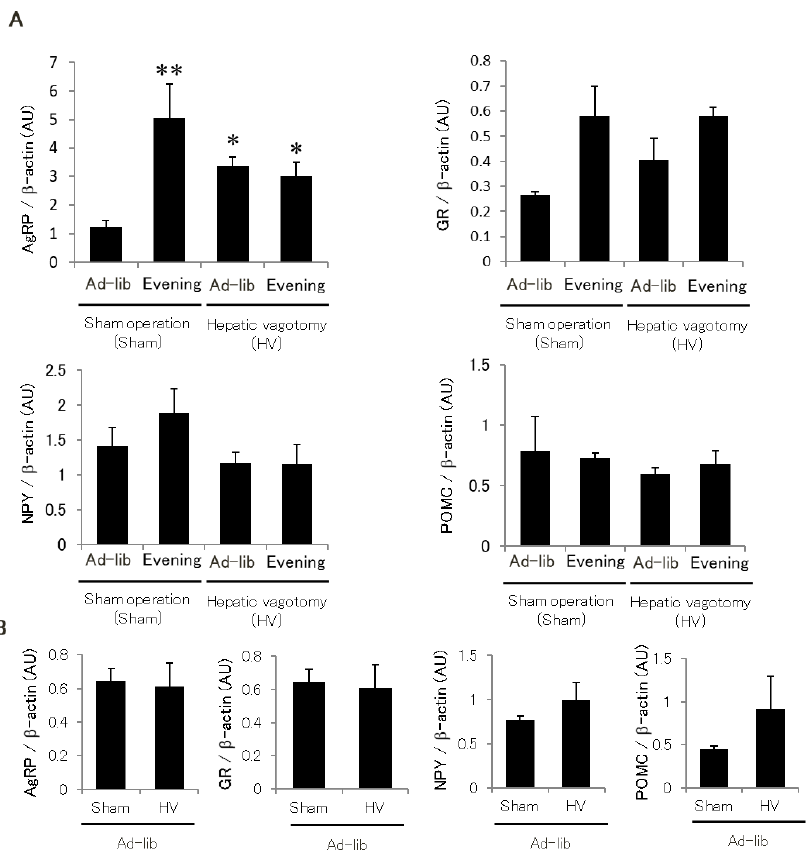
Figure 8. Effect of hepatic vagotomy on AgRP expression in ( A ) WT and ( B ) AgRP-GR-KO mice. ( A ) Hypothalamic AgRP, NPY, POMC and GR expression in WT mice with or without hepatic vagotomy ( n = 5). ( B ) Hypothalamic AgRP, NPY, POMC, and GR expression in AgRP-GR-KO mice in the Ad-lib group with or without hepatic vagotomy ( n = 5). Data are presented as mean ± SE, n = 4. * p < 0.05, ** p < 0.01 vs. Ad-lib (Sham).